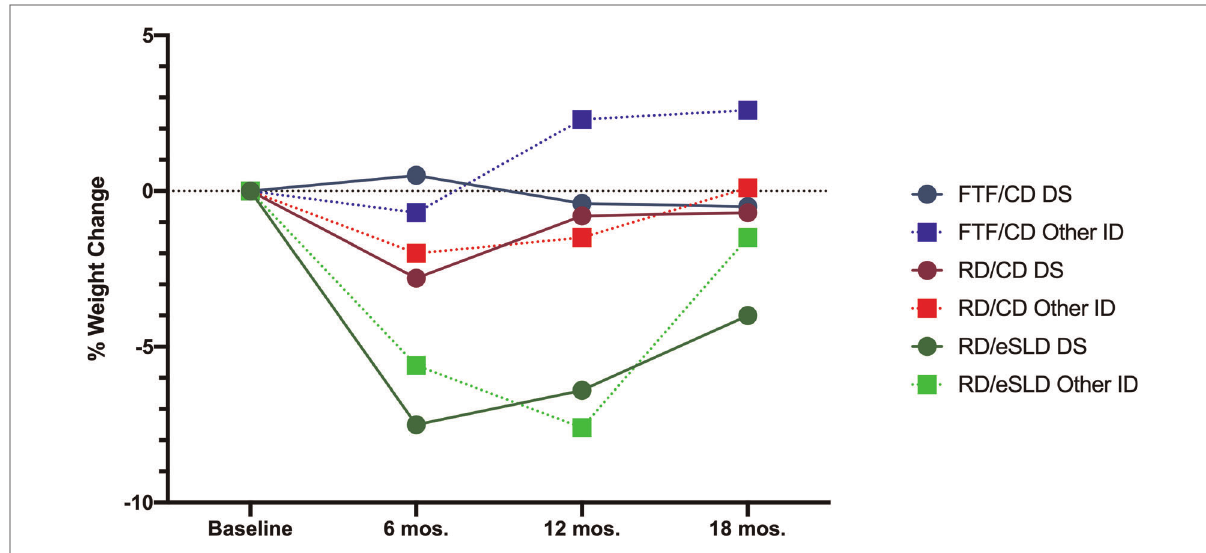
FIGURE 2 Percent weight change in adolescents with down syndrome (DS) or other intellectual disability (ID) across 18-months by intervention